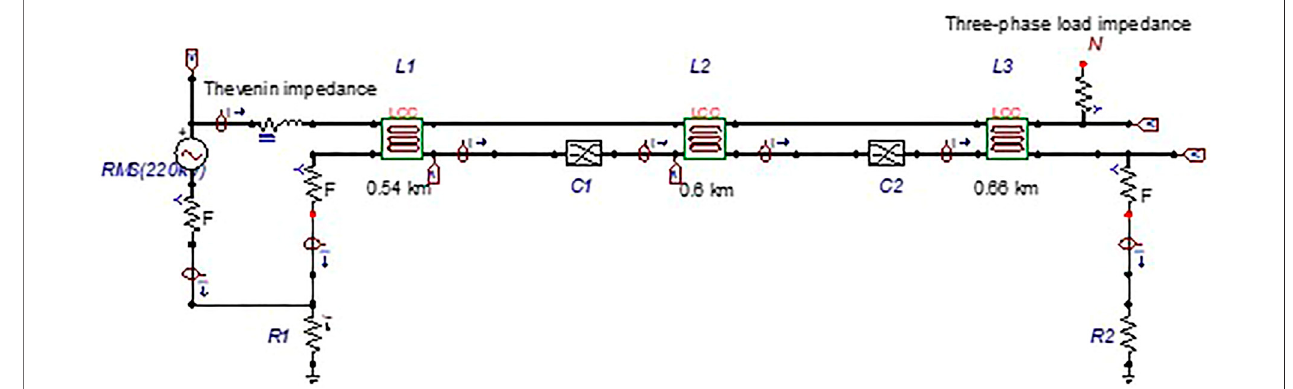
FIGURE 6 | Simulation model of induced current in cable sheath.